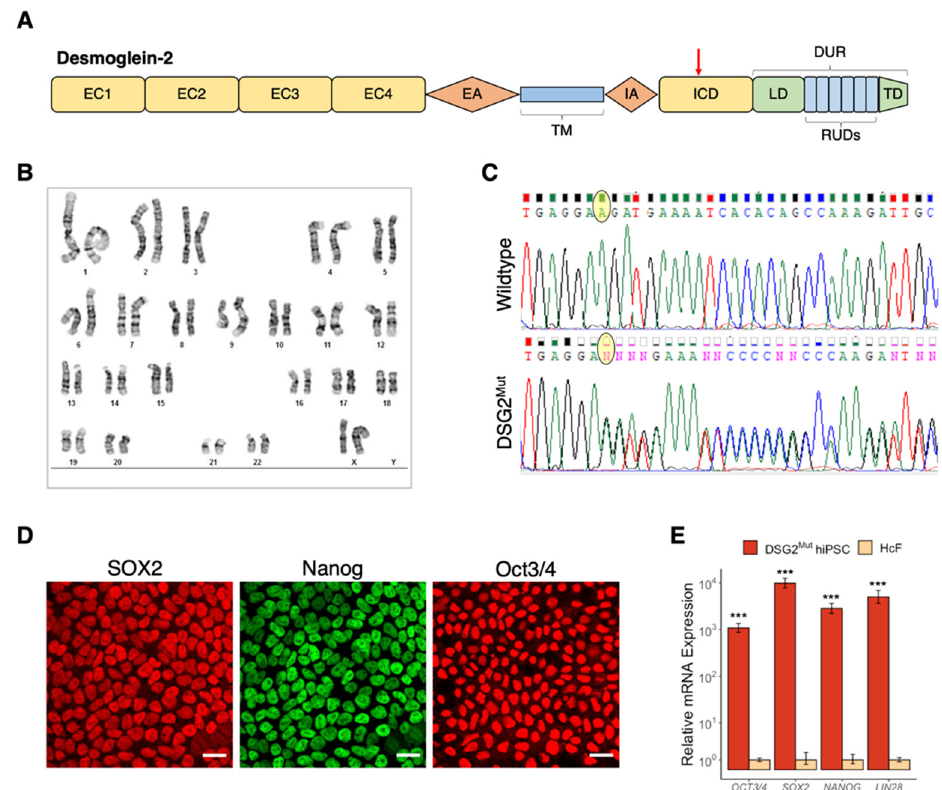
Figure 2. Donor-derived hiPSC line harbors heterozygous DSG2 c.2358delA variant and expresses markers of pluripotency. ( A ) Schematic protein structure of desmoglein-2. EC1–4, extracellular cadherin domains; EA, extracellular anchor domain; TM, transmembrane domain; IA, intracellular anchor domain; ICD, intracellular cadherin-like domain; LD, linker domain; RUD, repeat unit domain with 6 repeats; TD, terminal domain; DUR, DSG unique region; red arrow indicates location of truncation caused by the DSG2 c.2358delA variant. ( B ) Chromosomal analysis of JHU013 ( DSG2 Mut ) hiPSCs. ( C ) Sanger sequencing of DSG2 in control and DSG2 Mut hiPSCs showing the c.2358delA mutation. Yellow oval highlights c.2358 nucleotide under investigation. ‘N’ indicates likely heterozygosity at that location. ( D ) Confocal images of DSG2 Mut hiPSCs depicting immunopositivity for canonical markers of pluripotency: Sex determining region Y-box 2 (SOX2), homeobox NANOG, and Octamer binding transcription factor-3/4 (OCT3/4). ( E ) RT-qPCR analysis showed abundant expression of pluripotency-associated transcripts in DSG2 Mut hiPSCs relative to terminally differentiated control cells (primary neonatal human cardiac fibroblasts, HcF). n = 3 for each group. *** p <